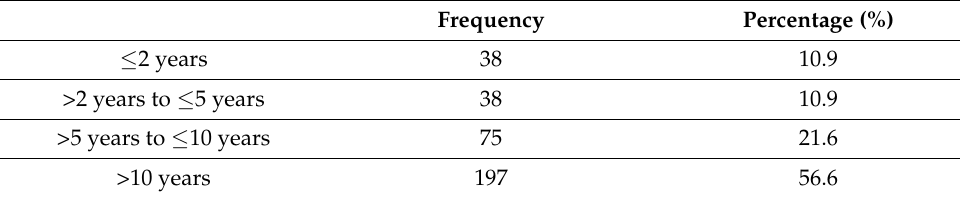
Table A5. Years of experience.